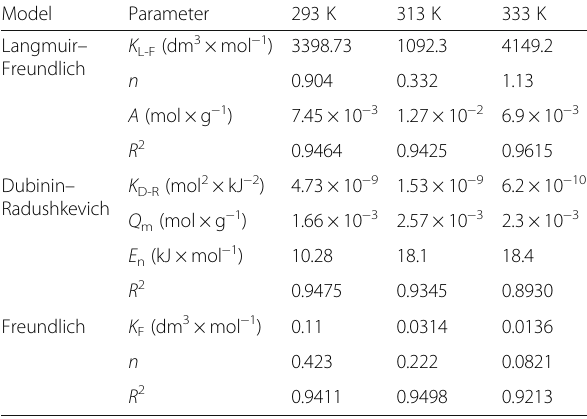
of adsorption of uranium ions is chemical in nature.